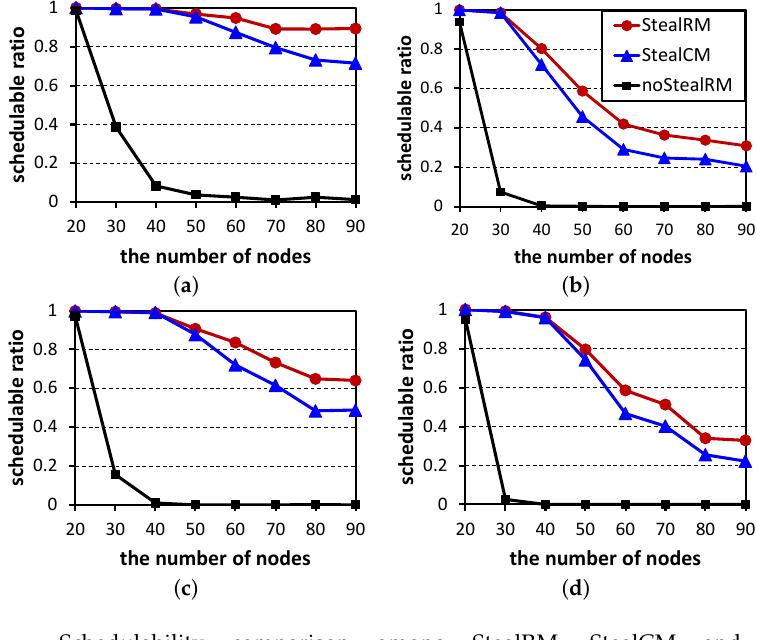
Figure 8. Schedulability comparison among StealRM, StealCM and